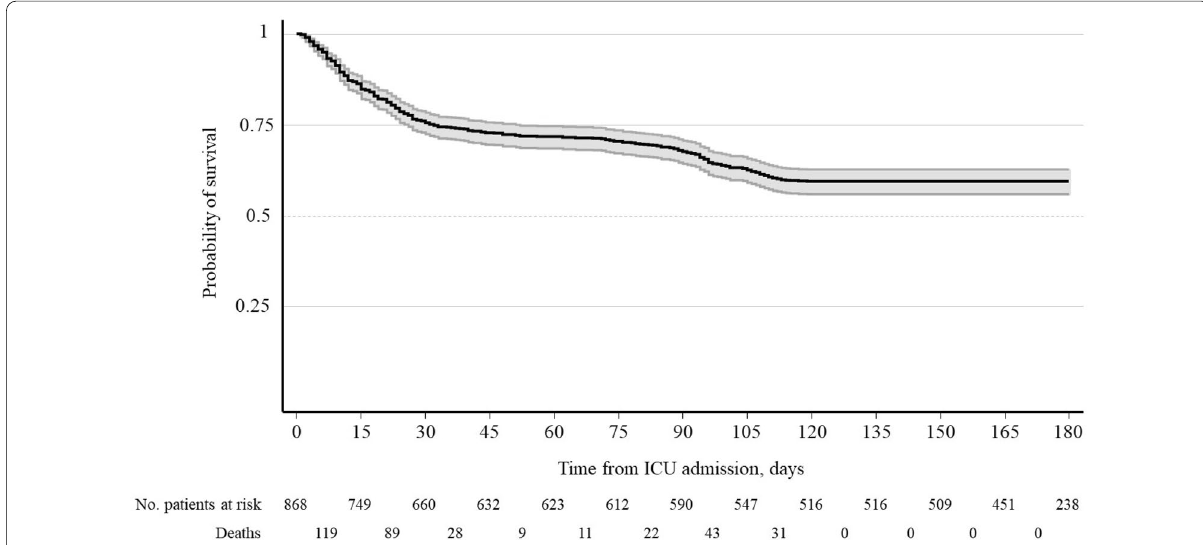
Fig. 1 Kaplan–Meier survival curves. Overall survival at 180 days. Grey lines represent the 95% confidence interval